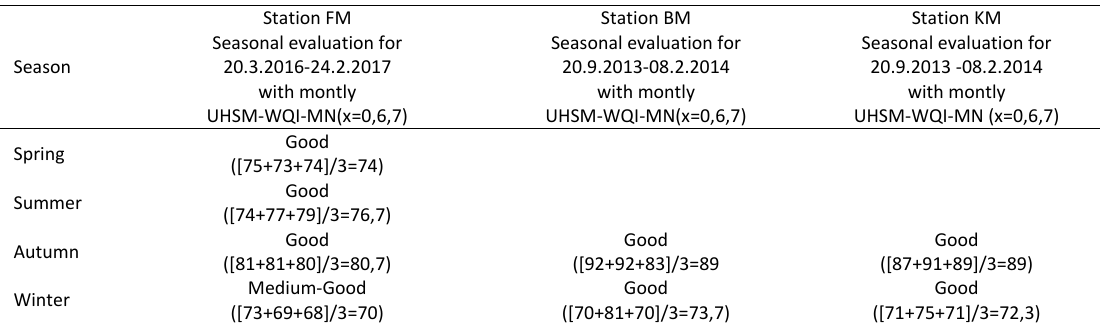
Fig. 11: Water quality index output from model with three input variables for stations KM and BM Fig. 10: Water quality index output from model with three input variables for stations KM and BM Table 2: A comparative water quality assessment at FM, BM and KM stations